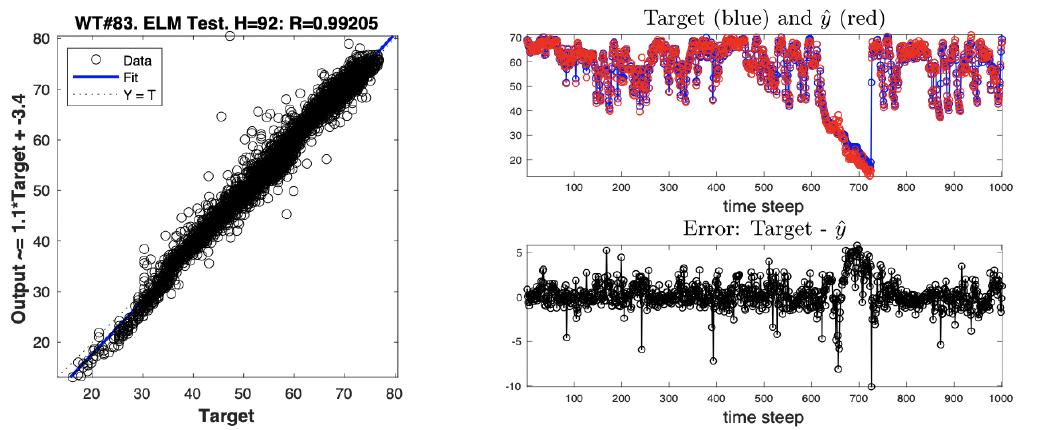
Figure 11. Test of the selected model ( H = 92) for the WT#83. On the left, the regression plot using all the test data. On the right, from a temporal window where the target ˆ y ( top ) and the error ( bottom ) can be observed in more